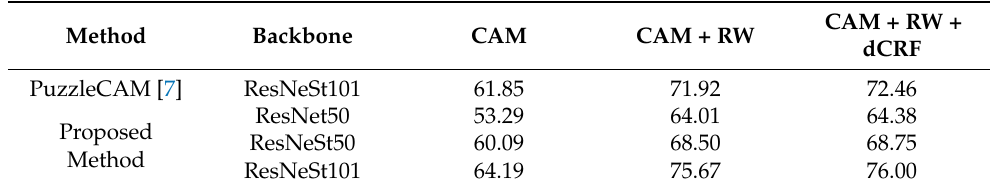
Table 4. Testing different backbones for generating pseudo masks in PASCAL VOC 2012 testing set in MIOU (%).